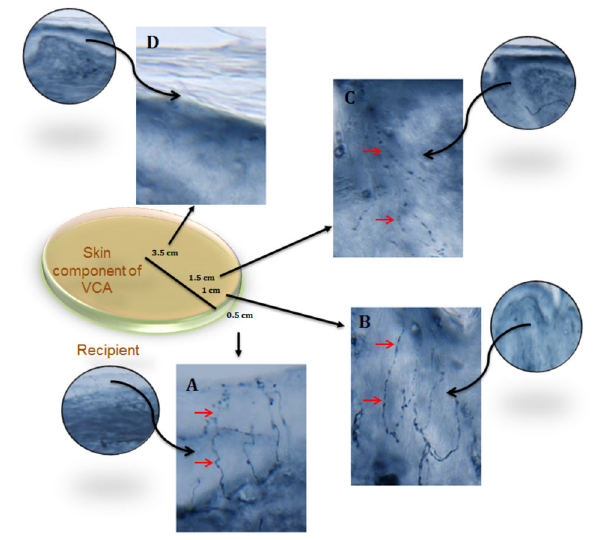
Figure 5. Sequential sections of skin component of allograft (Day 240 post-transplant). PGP9.5 (pan-axonal marker) demonstrates dense epidermal fibers (solid arrow) in native skin 0.5 cm away from the graft (A). Intra-epidermal fibers also visualized in skin component of VCA at 1cm (B) and 1.5 cm (C) away from the junction with native skin. No epidermal fibers seen in the center of alloflap (D).